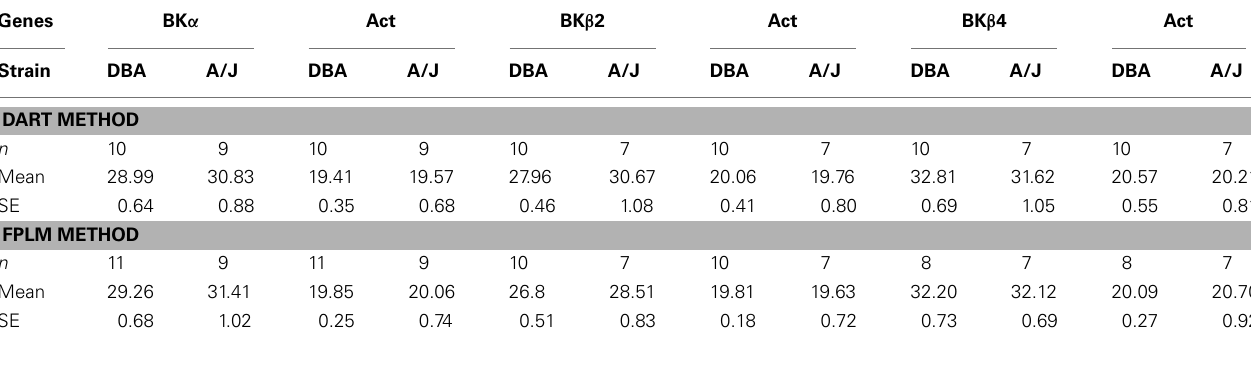
Table 1 | Gene expression of BK channel subunits: cCP values. Genes BK